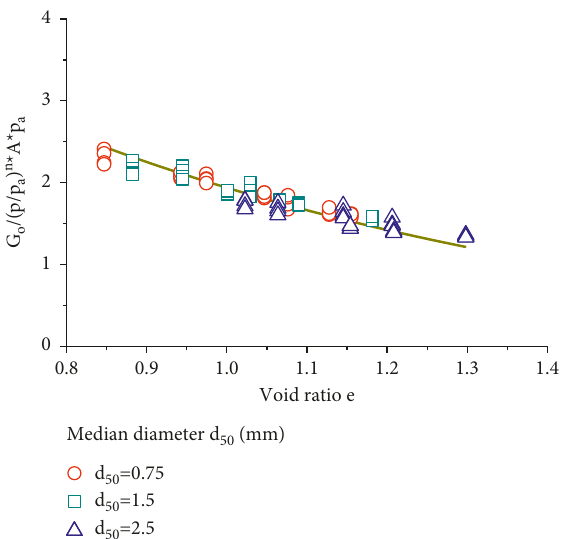
Figure 14: G ( p / p ) n Ap o / a a and void ratio for calcareous sands with three values of Cu.